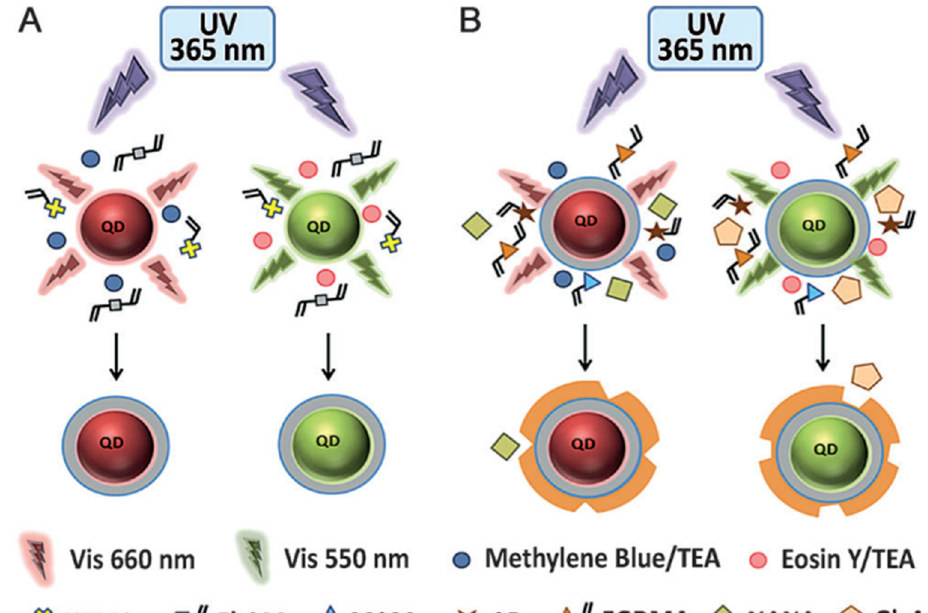
Figure 4. ( A ) Red or green light emitted from InP/ZnS QDs excited by UV irradiation is used to synthesize a polymeric shell in situ around the particles by photopolymerization. Methylene blue/trimethylamine (TEA) are used as the initiator system for red-QDs and eosin Y/TEA for green-QDs; ( B ) A second shell of MIP is synthesized by reinitiation in the presence of functional and cross-linking monomers and a molecular template (GlcA or NANA). Reproduced with permission from [46]. Copyright 2016 John Wiley & Sons.